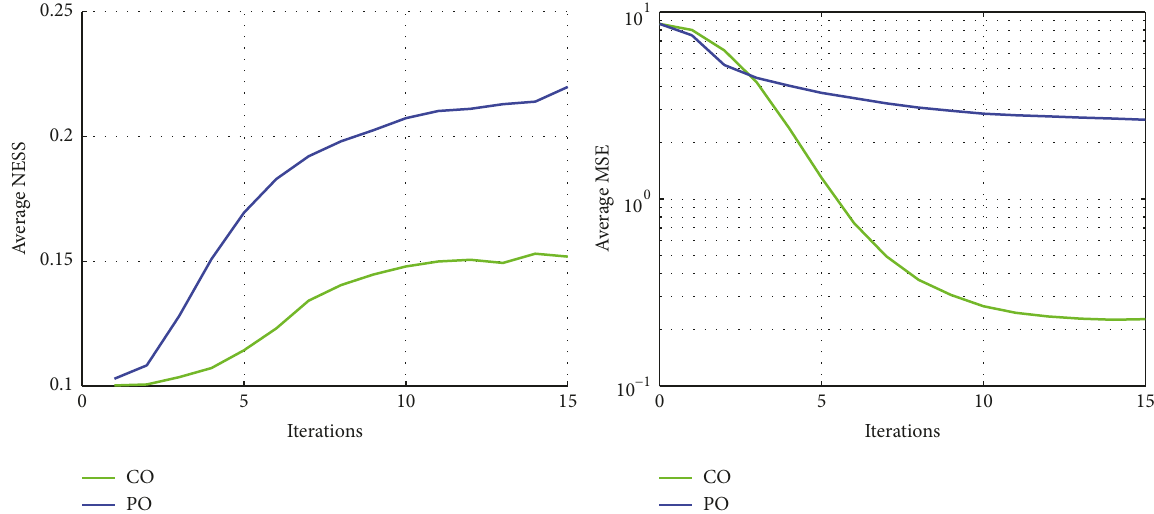
Figure 6: Evolution along the NPMC iterations of the average NESS ( left ) and MSE ( right ) in the CO and the PO scenario.